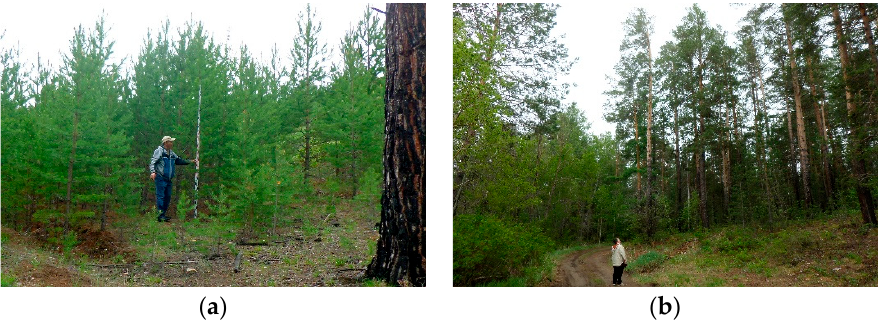
Figure 2. Pine forests ( a ) reforestation site and ( b ) reference site.